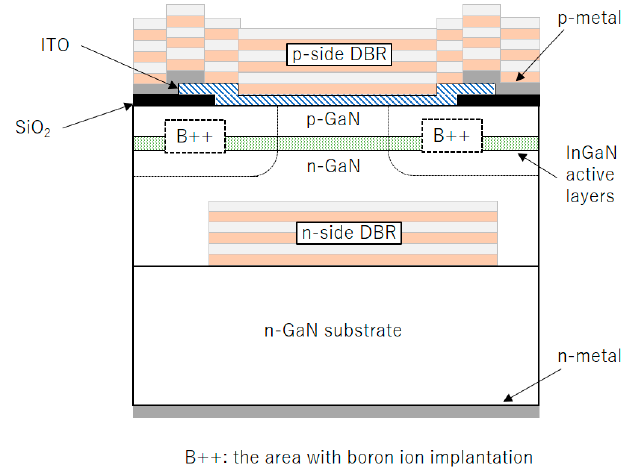
Figure 2. Schematic of an all-dielectric-distributed Bragg reflectors (DBR) gallium nitride based (GaN)-based VCSEL in which the bottom side DBR is encased in n-GaN generated using an epitaxial lateral overgrowth technique.